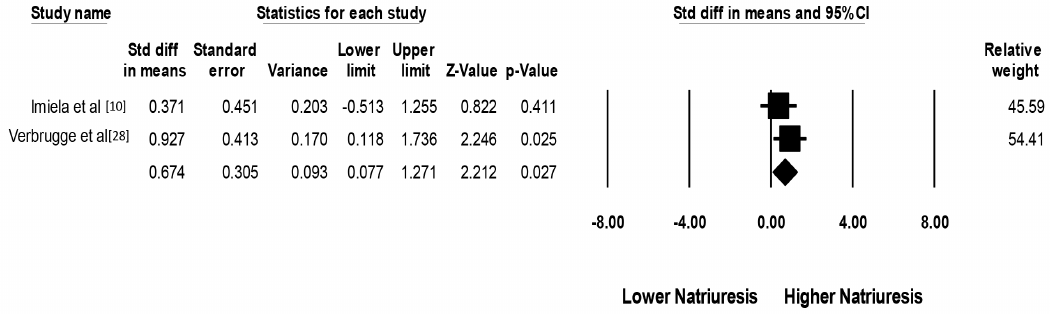
Figure 3. Forest plot of the included studies assessing effects of acetazolamide on natriuresis, when compared to control. A diamond data marker represents the overall rate from each included study (square data marker) and 95% CI.